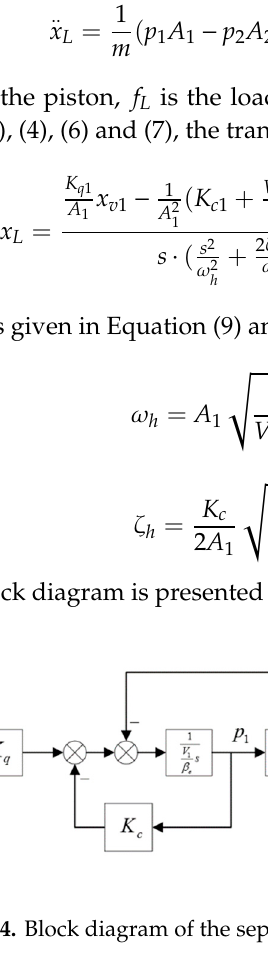
Figure 5 illustrates the block diagram of the separating-metering system with